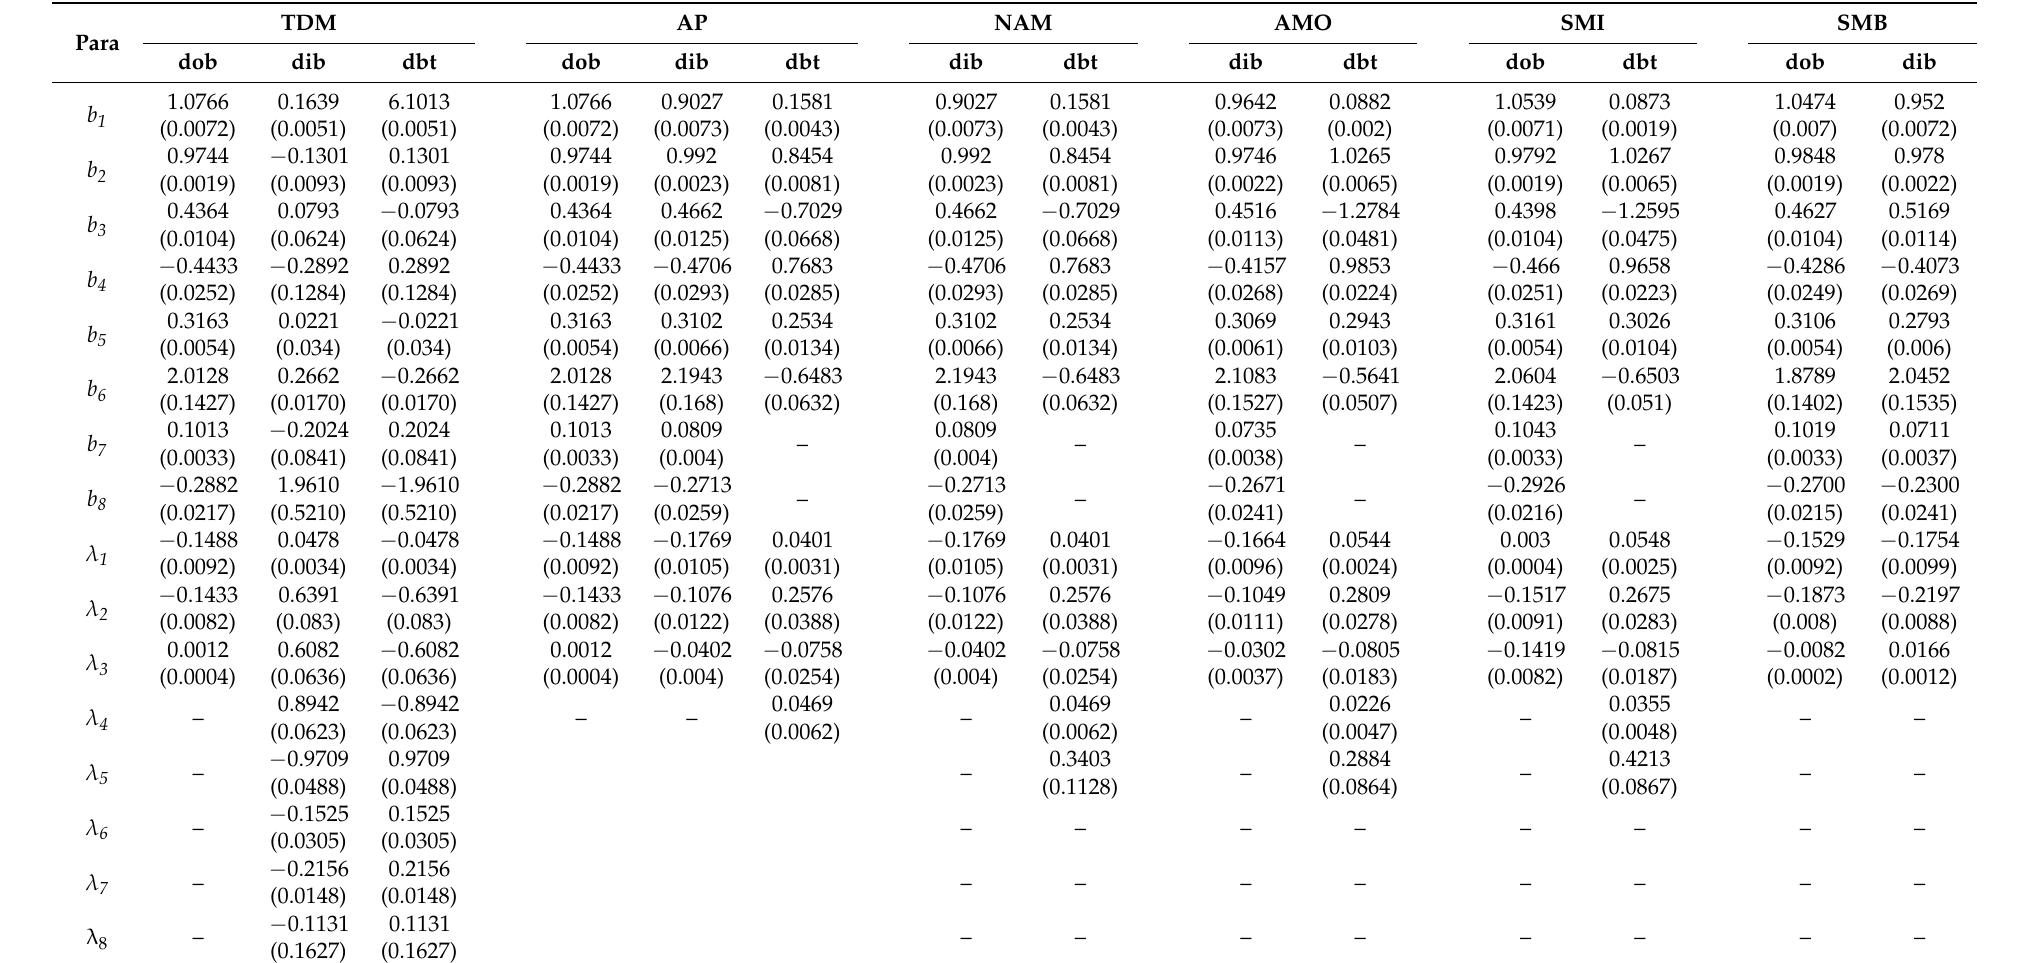
Table 4. Parameter estimate of the additive system with all